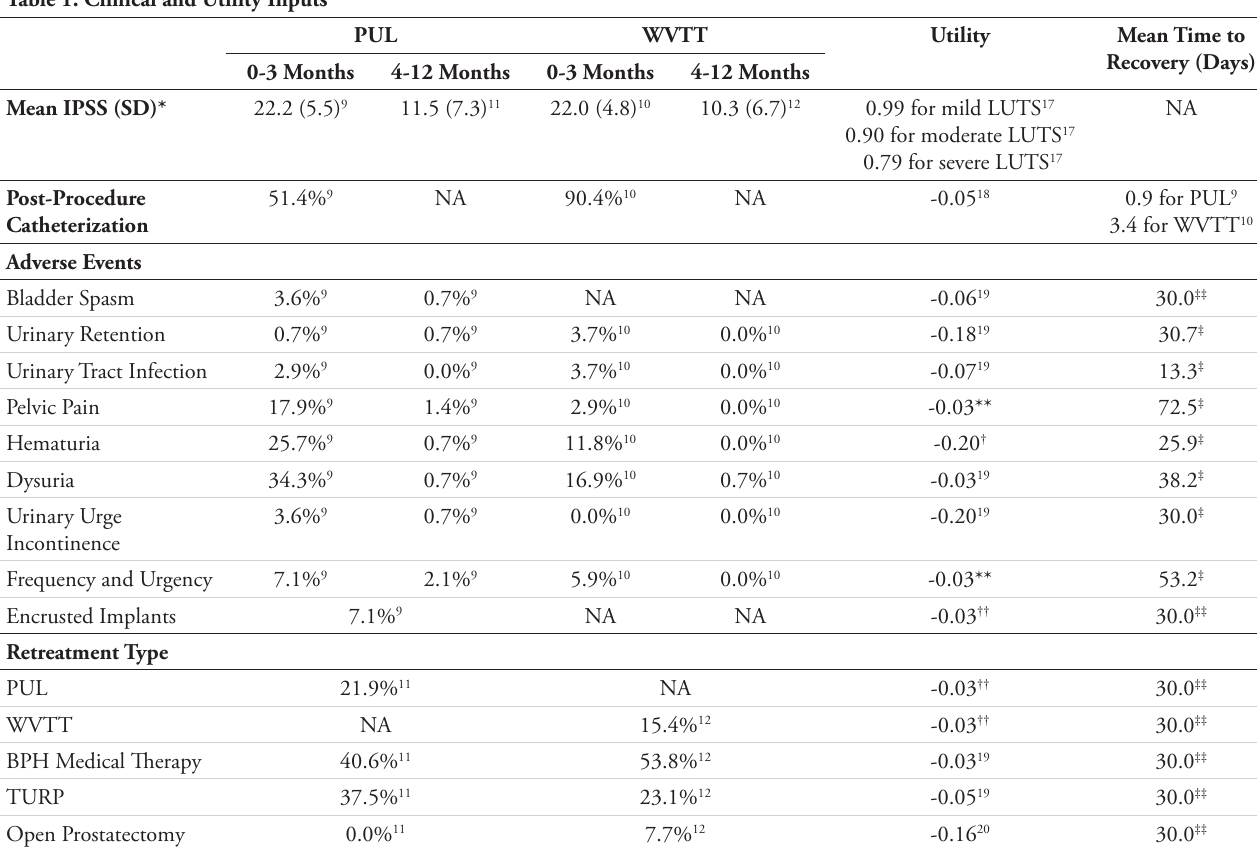
Table 1. Clinical and Utility